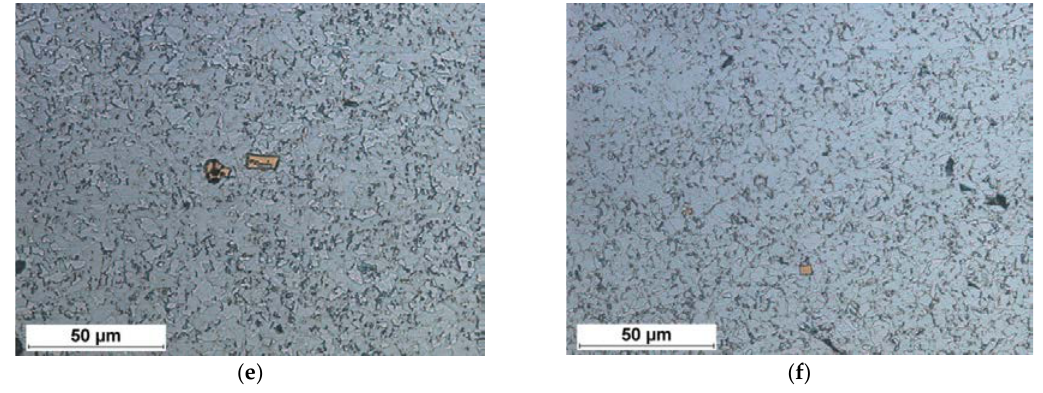
Figure 9. Microstructure of the hybrid welded joint (laser beam-MAG). ( a ) microstructure of the upper part of the weld, ( b ) microstructure of the lower part of the weld, ( c ) microstructure of the upper part of the fusion line, ( d ) microstructure of the lower part of the fusion line, ( e ) microstructure of the coarse-grained part of the HAZ, ( f ) microstructure of the fine-grained part of the HAZ.